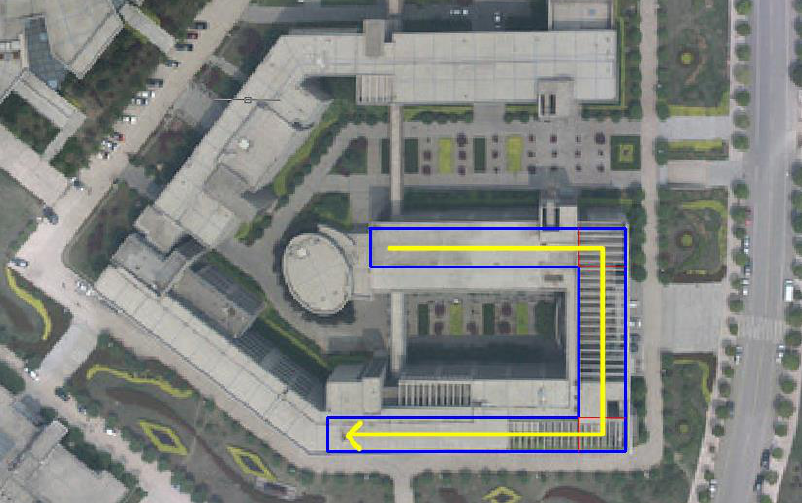
Figure 9. Test Route in the School of Environmental Science and Spatial Informatics (SESSI)